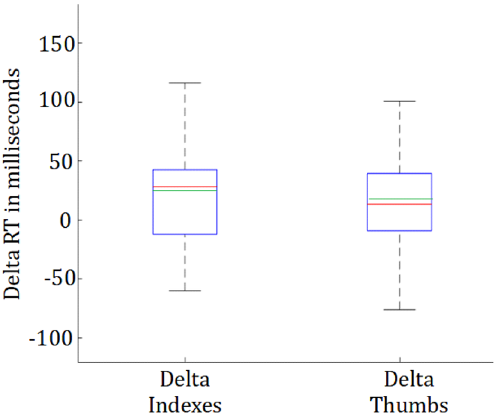
Figure 4. Change in the front and back button RTs between the far- Tactile and Tactile conditions. While we observed a general change in the RT values between the conditions, these changes were not different between the two button sets. The median is displayed in red, the mean in green and the first and third quartiles in blue. There were no outliers (non analyzed)